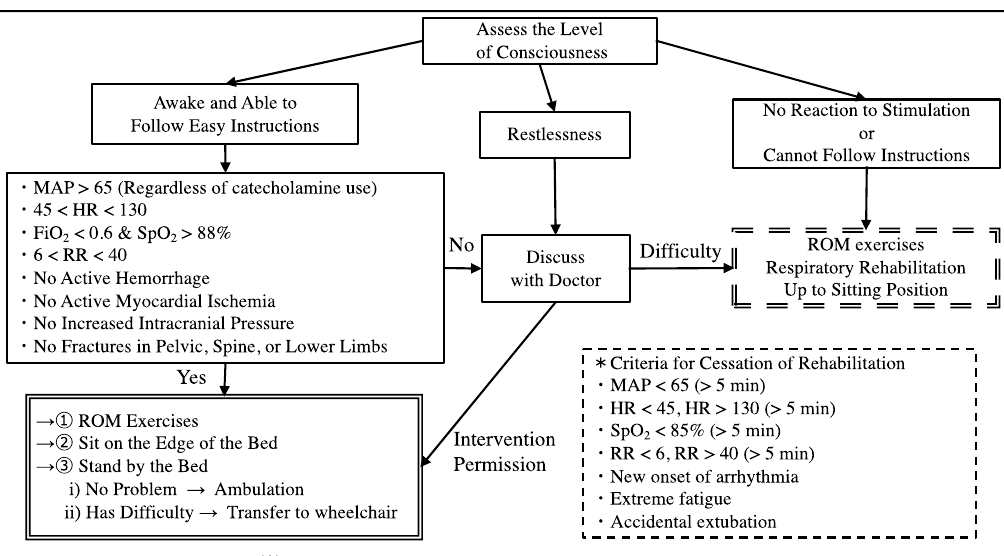
Figure 1 . The rehabilitation protocol used in our hospital. (1) We first assessed the level of consciousness. If the patient was awake and could follow easy instructions, we assessed their vital signs and physical findings. If satisfactory, we performed rehabilitation exercises out of bed as shown in the double-line box. Otherwise, we discussed with the physician whether it was possible to perform rehabilitation exercises. (2) If the patient showed restlessness, we also discussed this same issue with the physician. (3) If the patient did not react to stimuli and could not follow easy instructions, we performed rehabilitation on the bed as shown in the double-dashed-line box. If the patient met any of the criteria in the dashed-line box, we ceased rehabilitation. MAP = mean arterial pressure, HR = heart rate, FiO 2 = fraction of inspiratory oxygen, RR = respiratory rate, and ROM = range of motion.